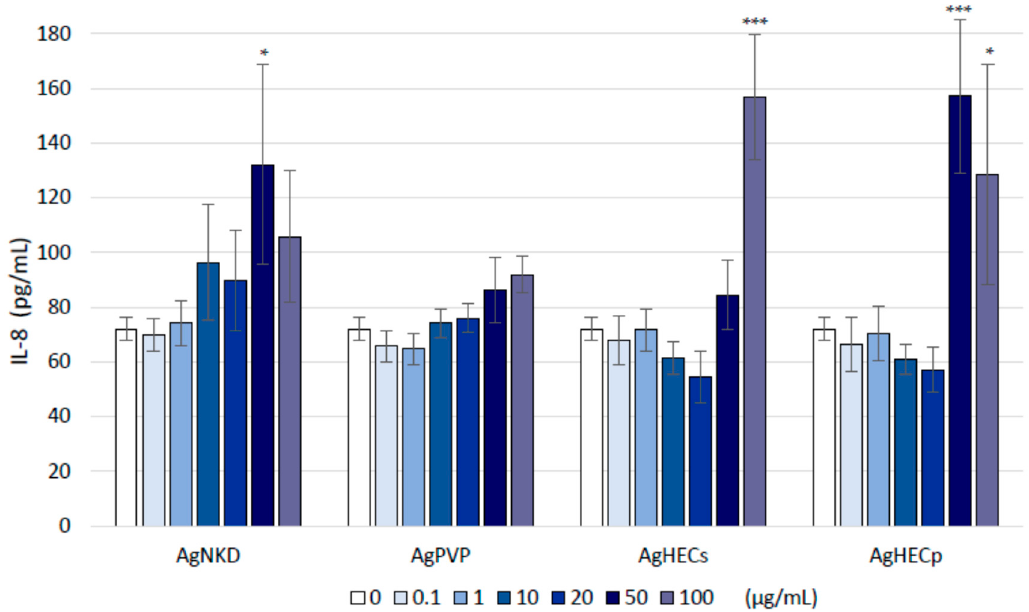
Figure 6. The inflammatory response (IL-8 release). IL-8 protein concentration was differently modulated by the NPs. Higher releases were observed at the higher exposure concentration of the AgHEC NPs (ANOVA followed by Dunnett’s test) and at the concentration for 50 µ g/mL AgHECp. Data are presented as the mean of the pg/mL release by each sample (n = 3) ± SE of at least three independent experiments. * p < 0.05 and *** p < 0.001 compared to control